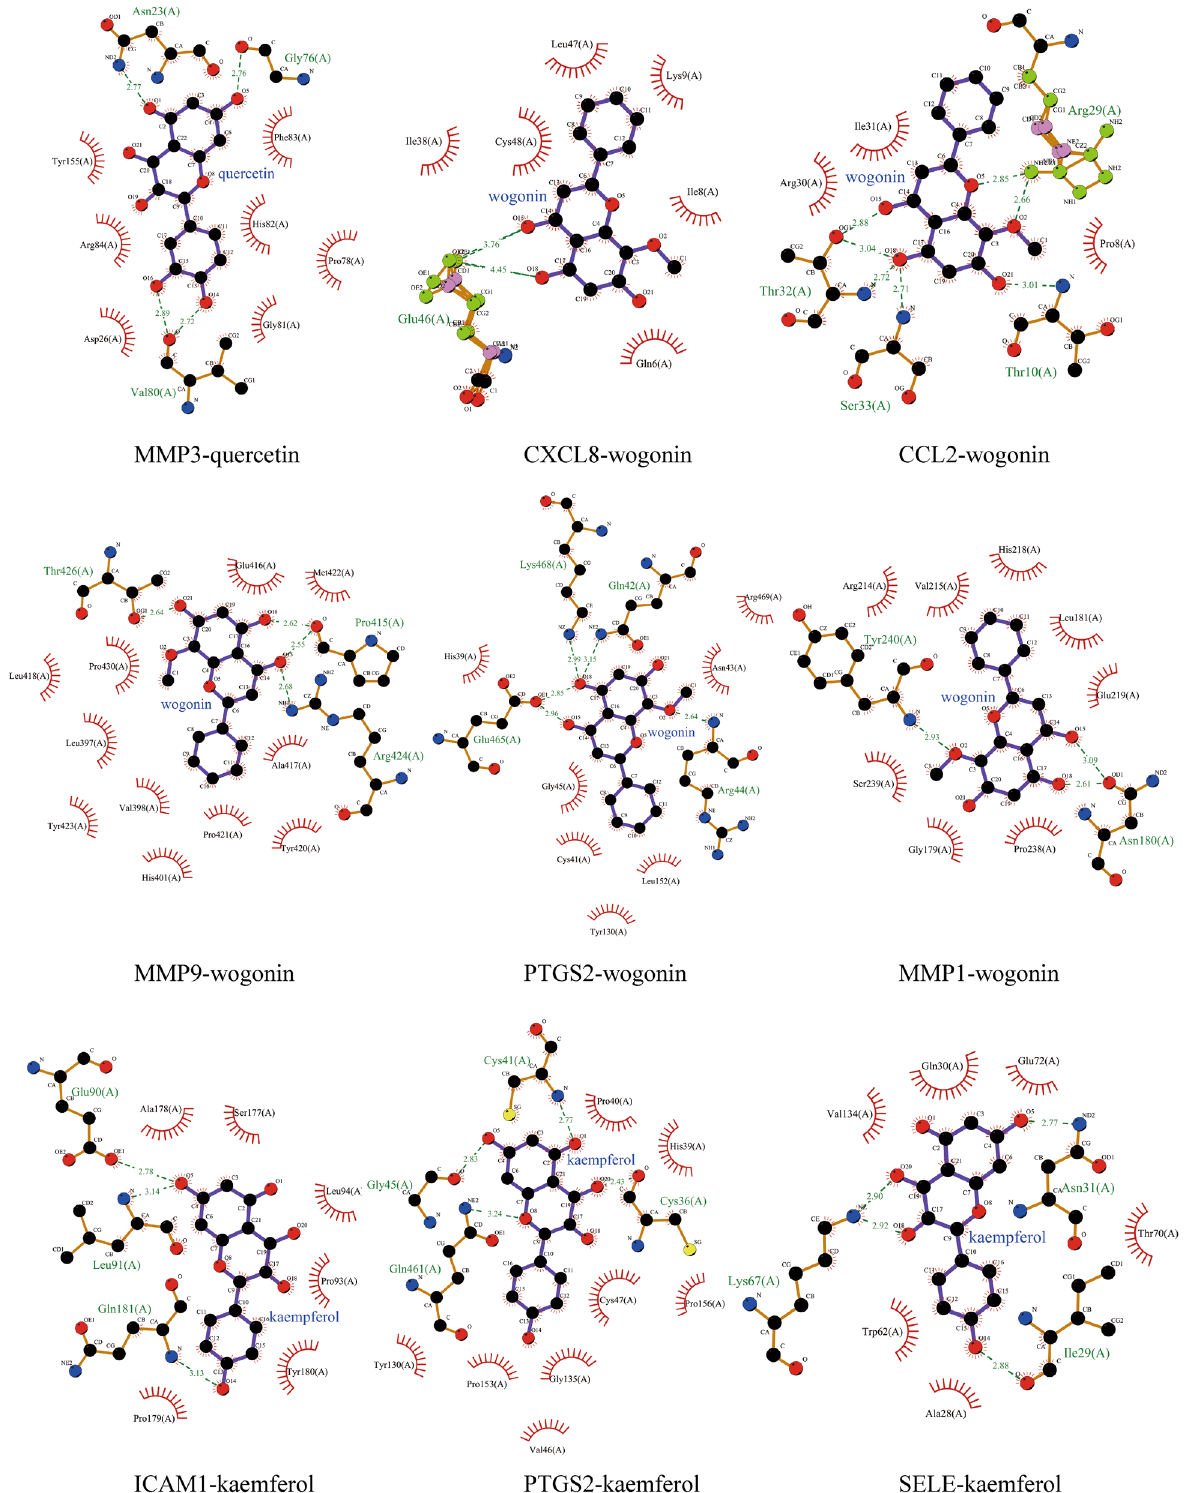
Figure 6. Molecular docking of active ingredients and hub targets. The picture shows the molecular interaction between the protein and the corresponding target, the receptor is highlighted in purple, and the hydrogen bond is shown in green font and the hydrophobic bond is shown in black